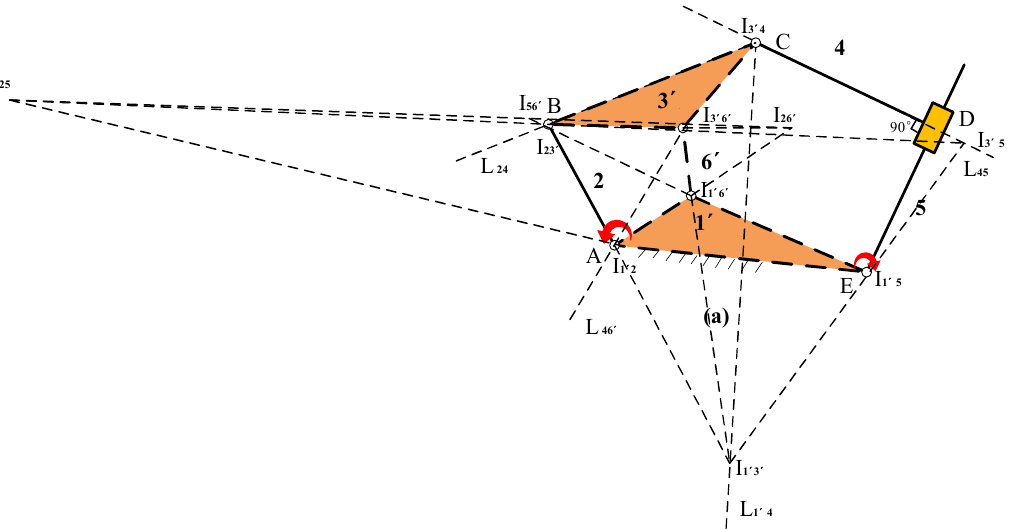
Figure 11. Single-loop five-bar planar linkage with ( a ) one prismatic joint, ( b ) two prismatic joints, ( c ) three prismatic joints.